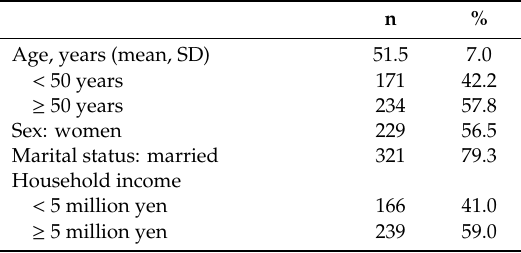
Table 1. Basic characteristics of study participants (n =